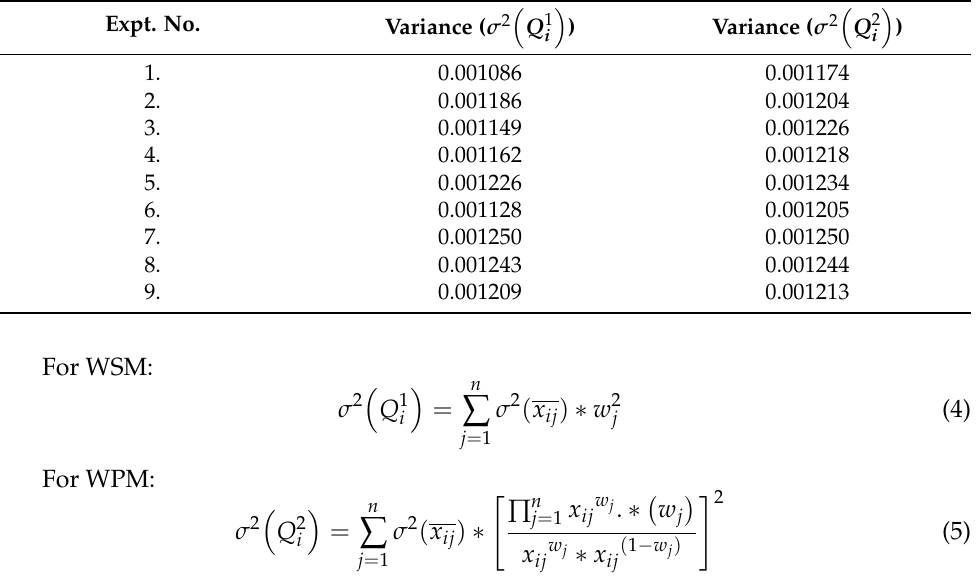
Table 5. Variance for WSM and WPM.